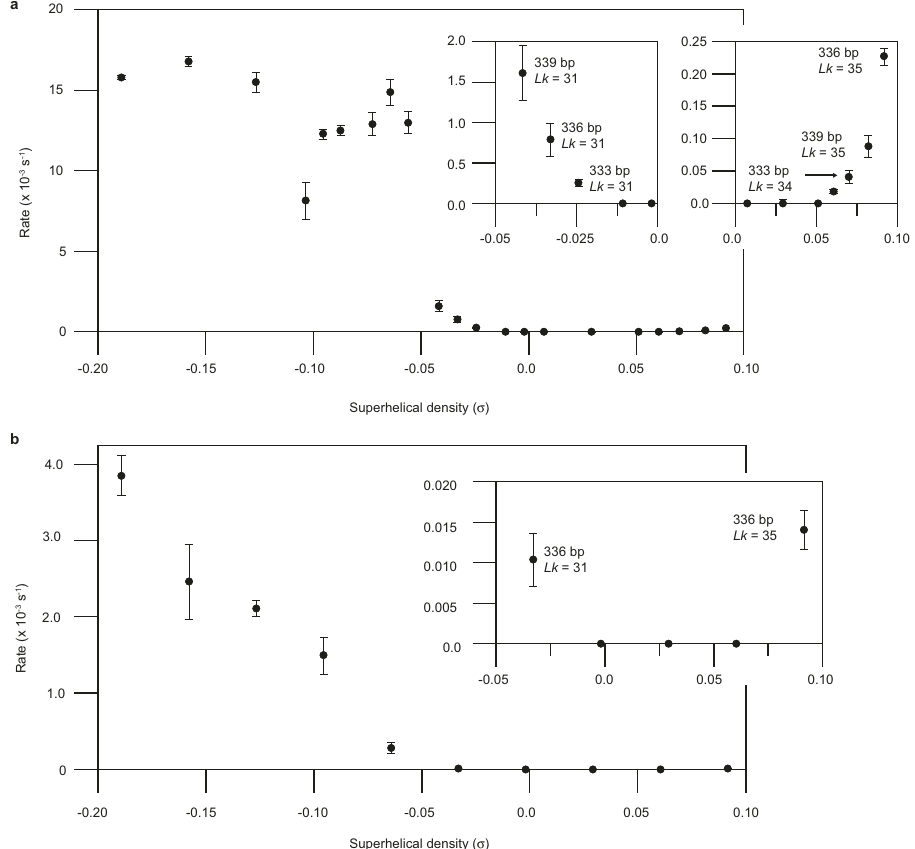
Fig. 4 DNA base exposure increases at a sharp threshold of supercoiling. a Comparison of Bal-31 cleavage rates as a function of superhelical density. Left inset, rescaled y -axis for data range σ = 0 to σ = − 0.05 to show the onset of Bal-31 activity with negative supercoiling. Right inset, rescaled y -axis for data range σ = 0 to σ = + 0.10 to show Bal-31 activity on positively supercoiled DNA. b Comparison of S1 nuclease cleavage rates as a function of superhelical density. Inset, rescaled y -axis for data range σ = − 0.05 to σ = + 0.10. Cleavage rates for Bal-31 and S1 nuclease were determined as described in “ Methods ” . Each kinetic assay was repeated at least three times and the mean values are shown. Error bars represent standard